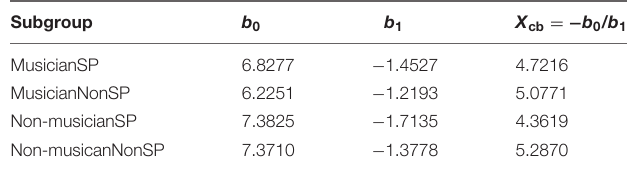
TABLE 1 | GEE estimates of regression coefficients ( b 0 , b 1 ) and the derived categorical boundary ( X cb ) for each subgroup (Musician and Non-musician Groups; Speech and Non-speech conditions).